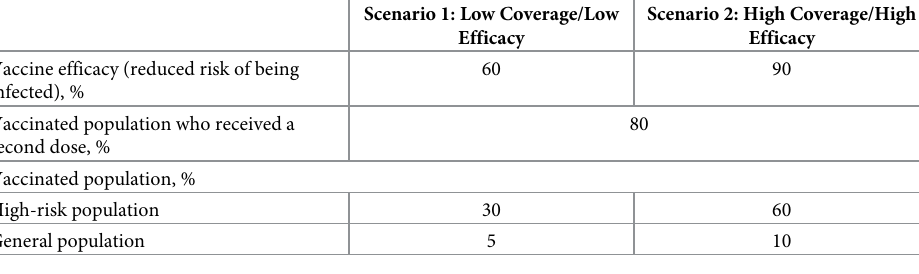
Table 2. Vaccination scenarios using the disease incidence